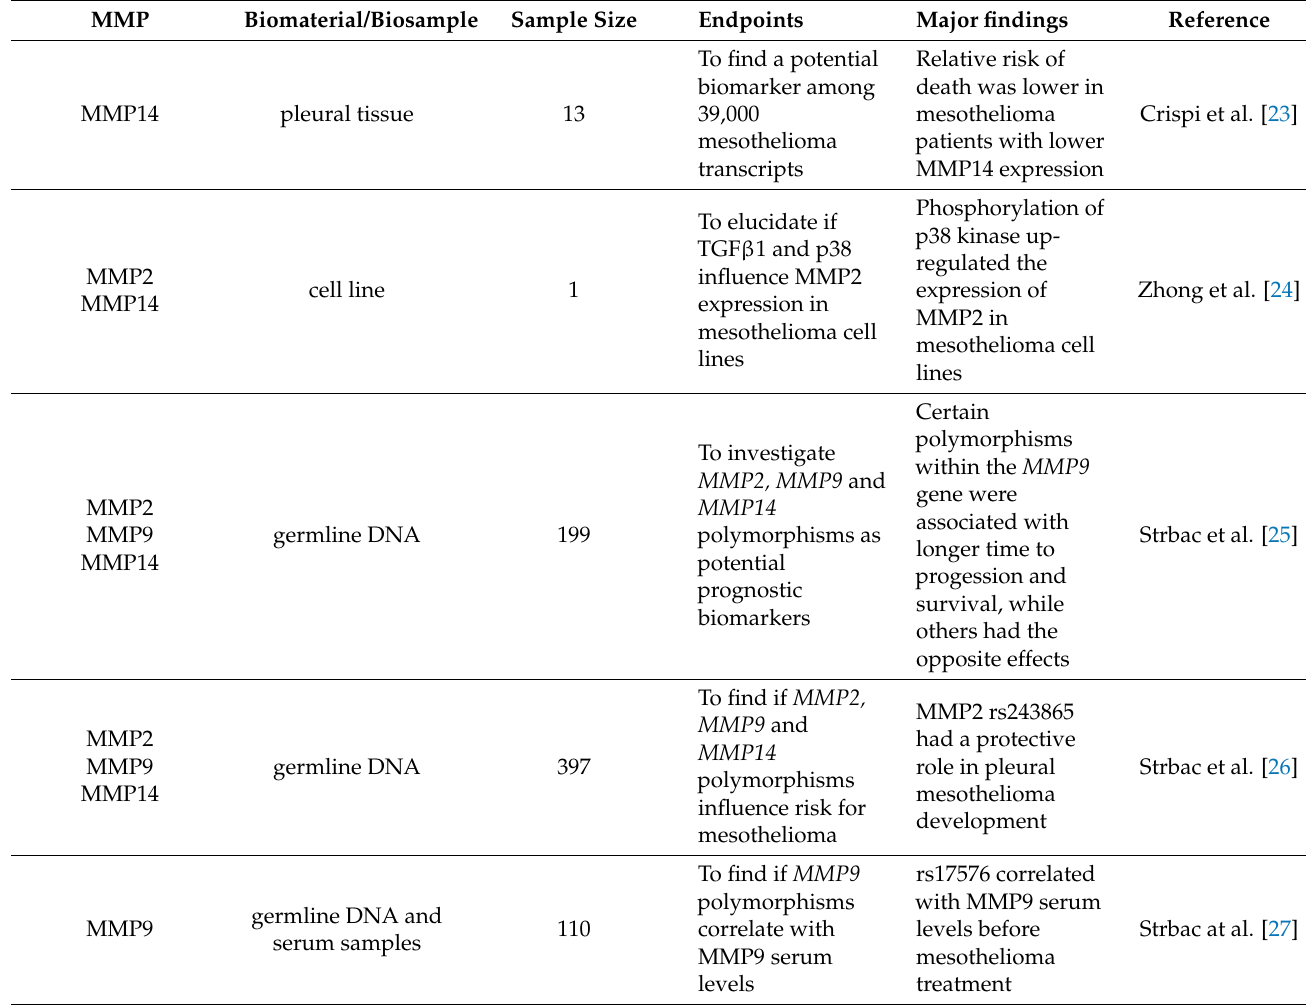
Table 2. Metalloproteinase (MMP) genetic variants in mesothelioma tissues or body fluids.